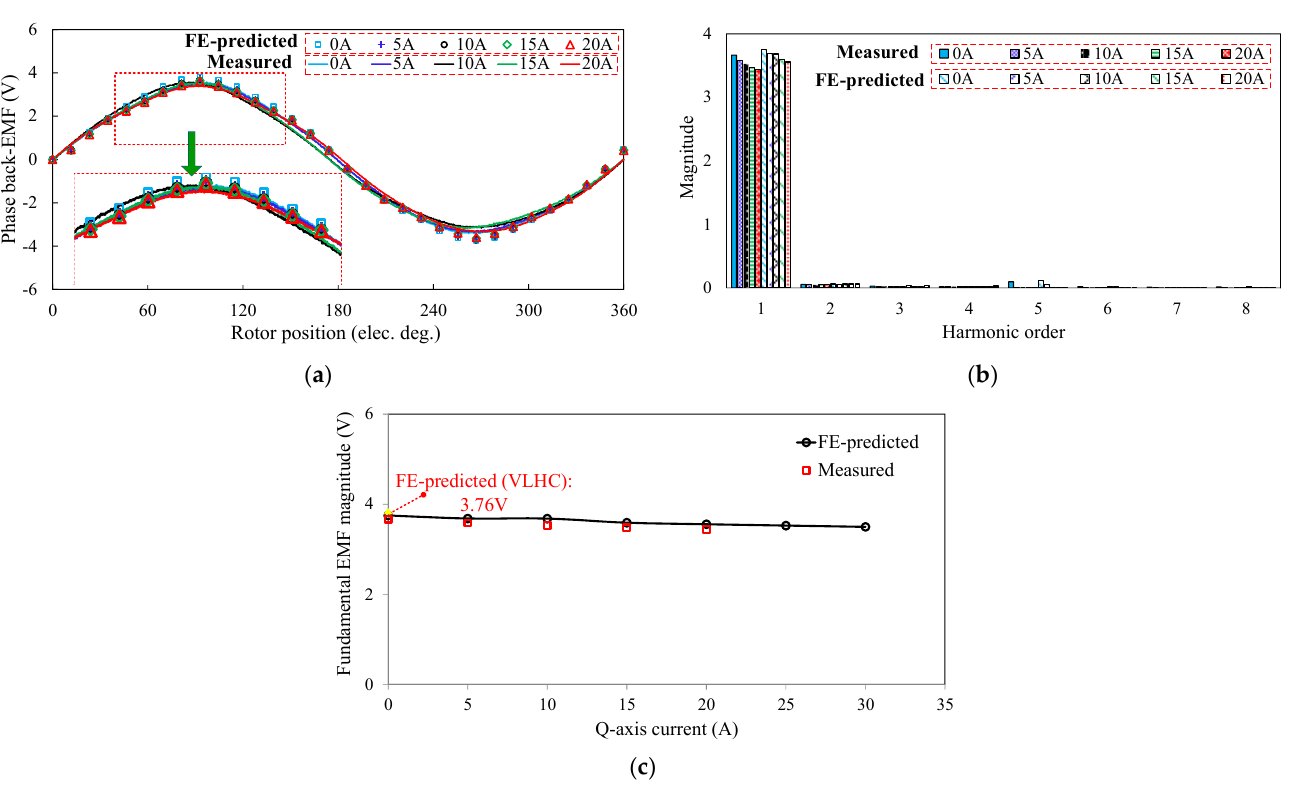
Figure 15. FE-predicted and measured open-circuit back-EMF characteristics before and after I q excitation, 400 r/min. ( a ) Waveforms. ( b ) Variation in fundamental magnitudes with applied q -axis current. ( c ) Comparison in fundamental magnitudes with applied q -axis current.